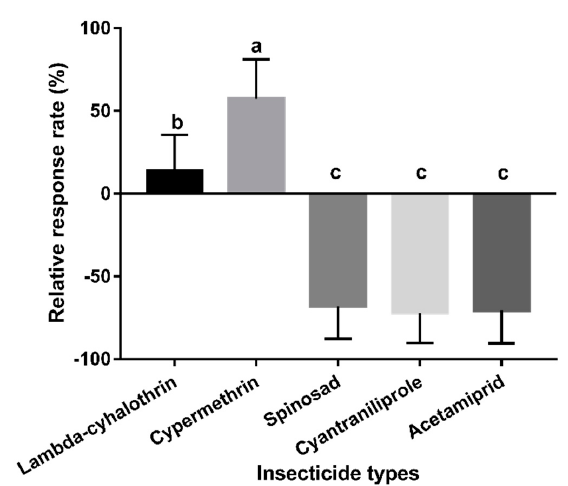
Figure 4. Behavioural responses of F. arisanus females to fly-infested mangoes sprayed with different insecticides. The data are expressed as mean ± SD. Different lowercase letters denote significant differences by Tukey’s multiple range test ( p < 0.05). N = 15.